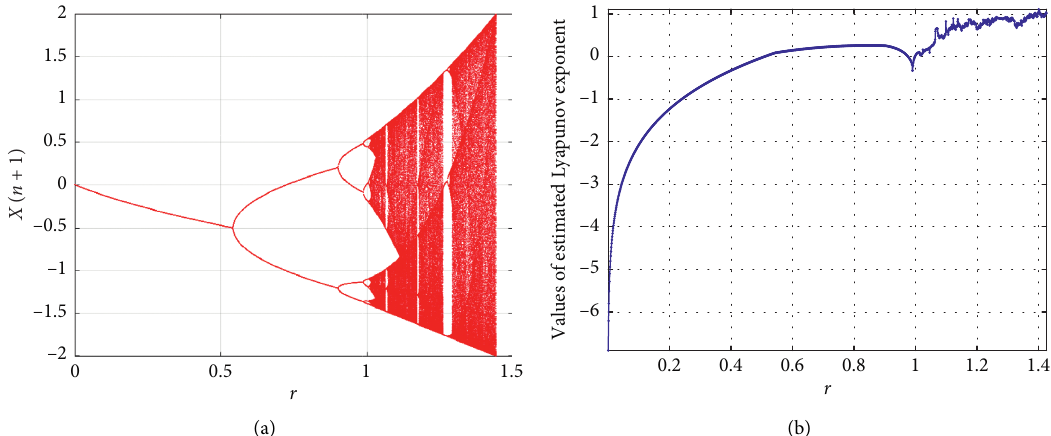
Figure 3: The Bifurcation diagram (a) and Lyapunov exponent (b) for the first proposed map at x